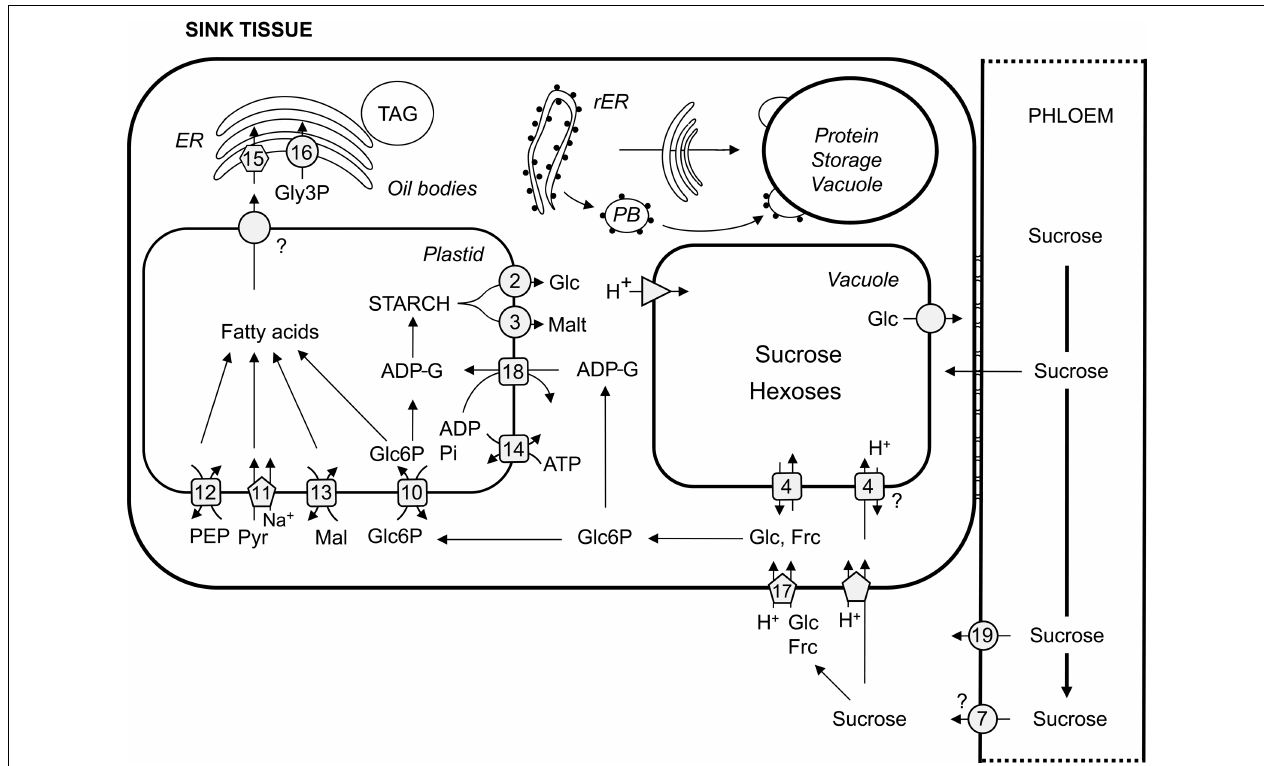
16, Gly3P permease; 17, HT; 18, BT-1; 19, SUF1. (r)ER, (rough) endoplasmic reticulum;TAG, triacylglycerol; PB, protein body; PEP, phosphoenolpyruvate; Pyr, pyruvate; Mal, malate; Glc6P, glucose 6-phosphate; Pi, orthophosphate; ADP, adenosine diphosphate; ADP-G, ADP-glucose; Glc, glucose; Malt, maltose; Frc, fructose. Please refer to text for transporter